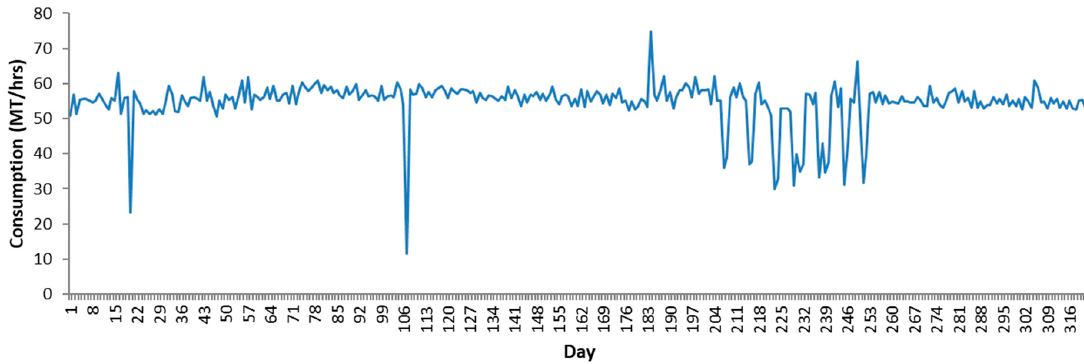
. Figure 7. Schematic representation of the proposed model. 4. Results